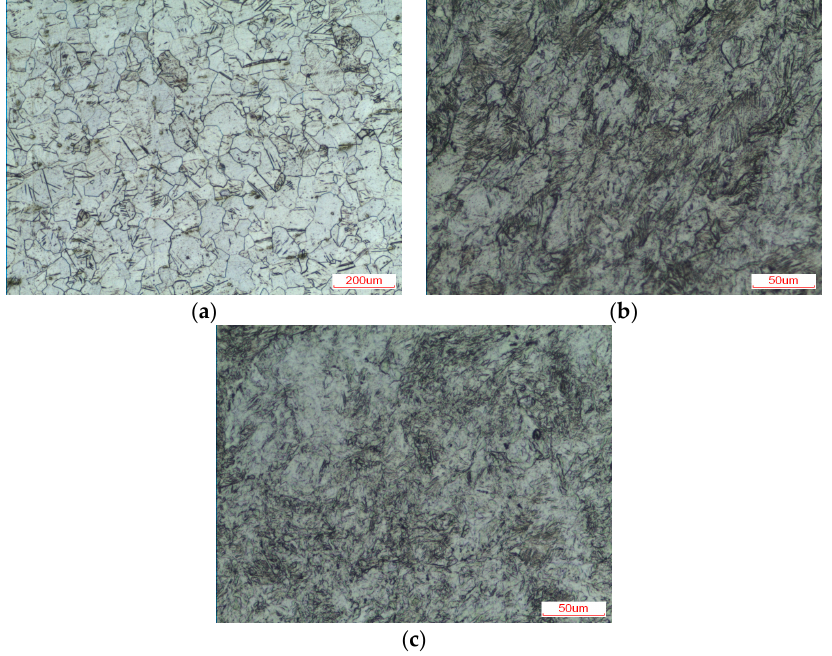
Figure 3. Optical micrographs of CP-Ti at different processing stages: ( a ) as-received; ( b ) after 4 passes ECAP; ( c ) after 8 passes ECAP.